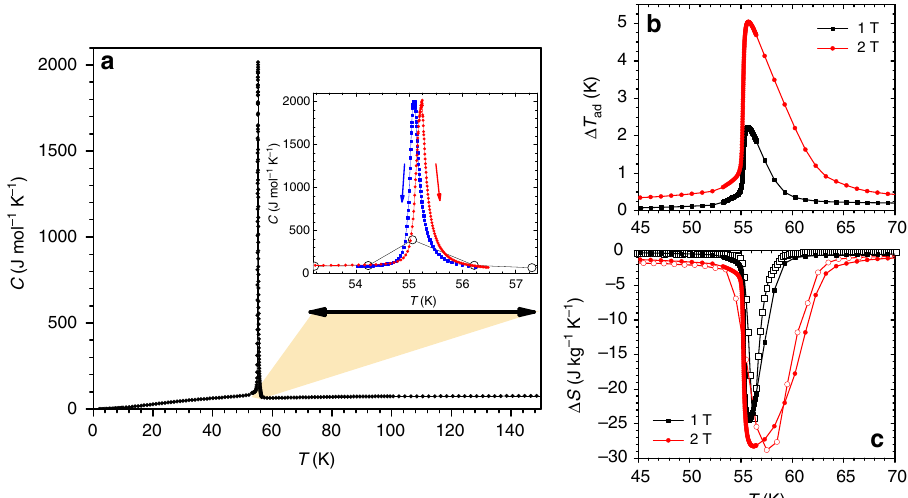
Fig. 3 Heat capacity and magnetocaloric effects of Eu 2 In. a Heat capacity ( C ) as a function of the temperature ( T ) measured on heating in zero magnetic fi eld. The inset shows the heating and cooling branches calculated using the single pulse method (SPM, fi lled squares) compared to the standard analysis of the Multiview software Quantum Design (open circles). b Adiabatic temperature change ( Δ T ad ) for magnetic fi eld changes of 1 and 2 T derived from calorimetry. c Isothermal entropy change ( Δ S ) determined from calorimetry ( fi lled symbols) and magnetization (open